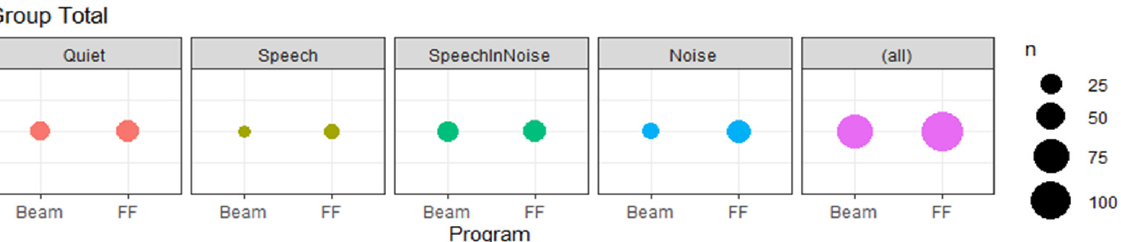
Figure 2. Program preference accumulated across entire subject group separated by sound class. Size of data point indicates number of votes. “BEAM” specifies the program consisting of the algo- rithms ADRO, SNR-NR, ASC and BEAM. “FF” indicates the second program containing the For- wardFocus microphone technology.